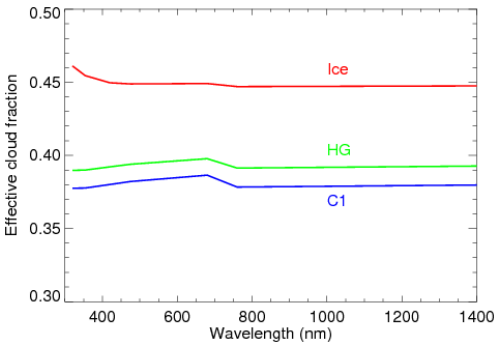
Figure 1. The spectral dependence of the effective cloud fraction ( f c ) for land, f g = 0 . 5, SZA = 45 ◦ , observation at nadir. Red: ice cloud phase function; green: the Henyey–Greenstein (HG) function; blue: C1 cloud model.